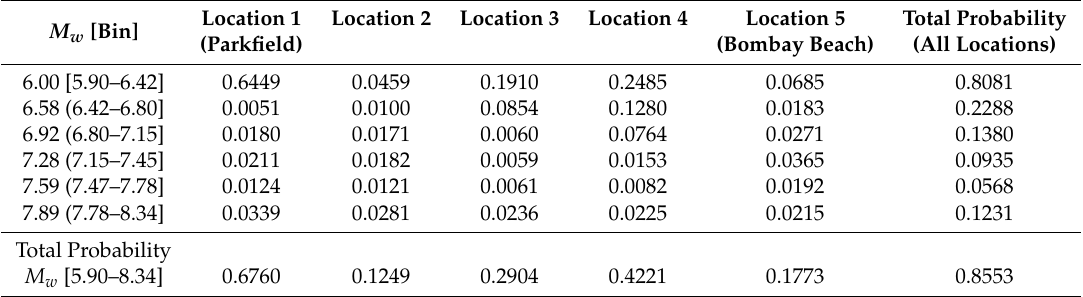
Table 2. UCERF3 time-independent 30-year occurrence probabilities for the 30 scenario earthquakes (six magnitudes and five rupture locations). Half of these probabilities are assigned to north-to-south propagating ruptures and the other half to south-to-north propagating ruptures. Location 1 Location M w [Bin]